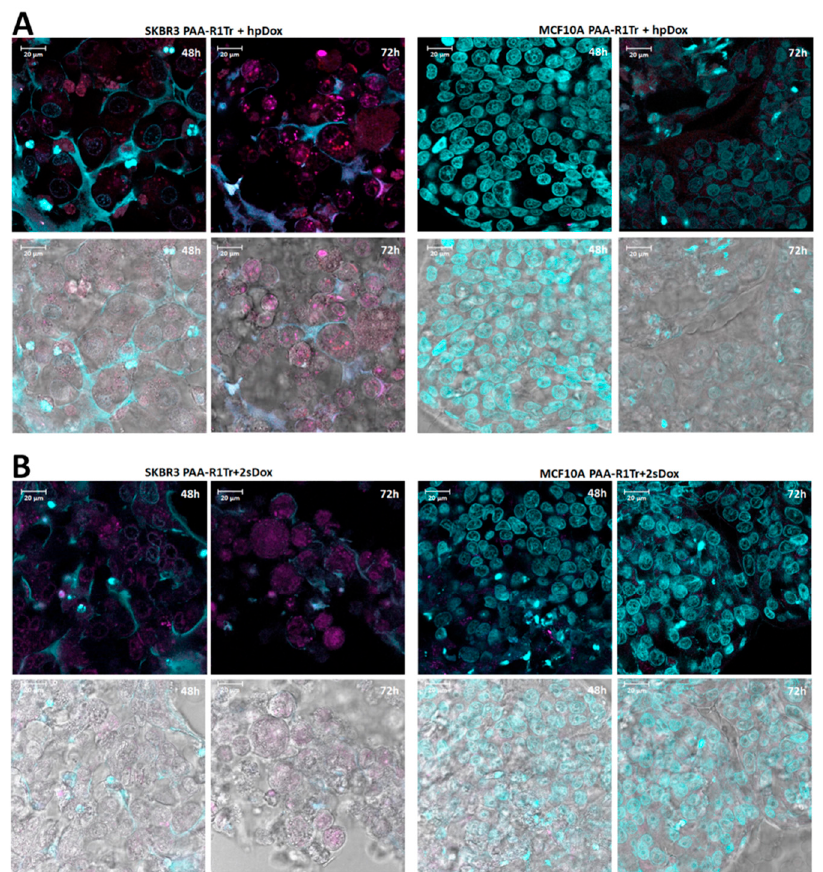
Figure 8. Images of SKBR3 spheroids (left half of each image set) and MCF10A spheroids (right half of each image set) incubated with polymeric SKBR3-R1Tr aptamers and Dox loaded Dox boxes (see Figure 2 and main text) for, respectively, 48 and 72 h. Panel ( A ): SKBR3-R1Tr + hairpin Dox box (hpDox) of which 1 in every 10 Dox boxes is Alexa Fluor 594 labeled. Panel ( B ): SKBR3-R1Tr + 2-strand Dox box (2sDox). The bottom row of each panel is the bright field image of the fluorescent image above.